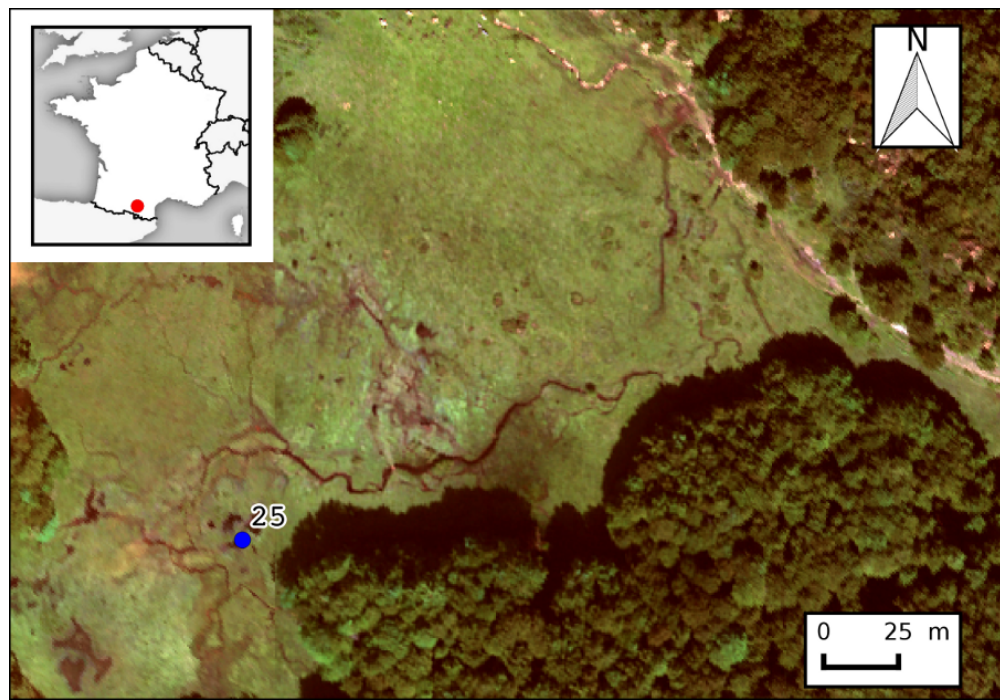
Figure A19. Location of the in situ spectroradiometer measurements for the plots of Aquatic type b (AQ_B).